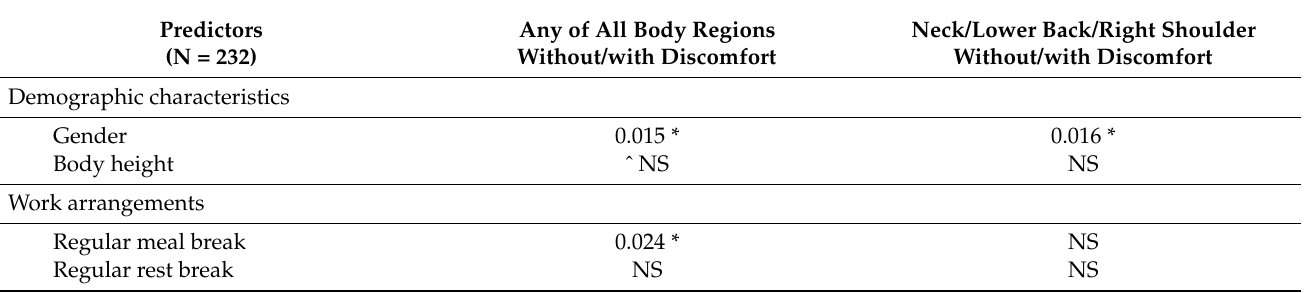
Table 10. Summarised results of demographic characteristics and work arrangements factors associ- ated with musculoskeletal